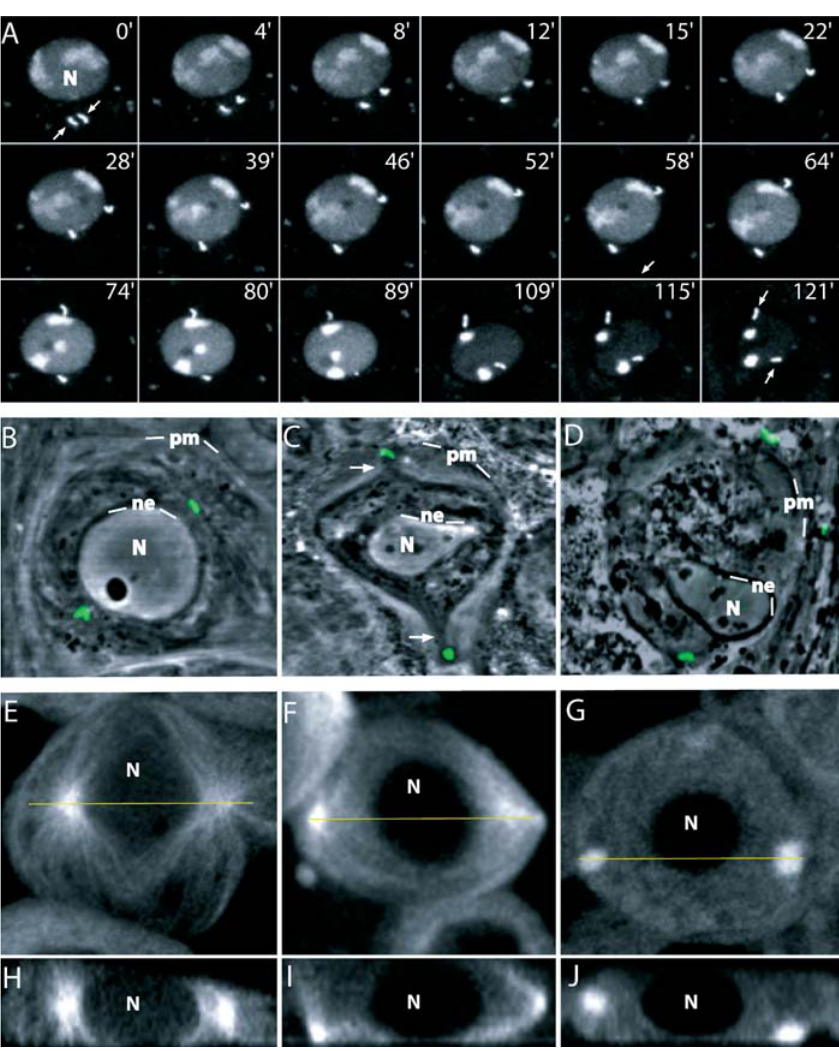
Figure 1. Centriole Migration in Primary Spermatocytes (A) Time-lapse series of confocal images from a wild-type primary spermatocyte expressing GFP-PACT (centrioles) and His2AvD–GFP (chromosomes). The cen- trioles (arrows) can be seen moving away from the plasma membrane (0) towards the nucleus (N) and then migrating diametrically apart as the chromatin condenses. The chromosomes are fully condensed at timepoint 121 min. (B–D) The two centriole pairs (green) projected over the phase-contrast view (grey) can be seen close to the fenes- trated NE and away from the plasma membrane (pm) in control cells (B), while they remain plasma membrane- bound in asp (C) and in colcemid-treated wild-type cells (D). In asp spermatocytes (C), the position of the membrane-bound centrioles correlates tightly with the pointed end of phase-dark protrusions (arrows) that are not present in colce- mid-treated cells. These reflect the dis- tribution of phase-contrast membranes known to overlap microtubules in these